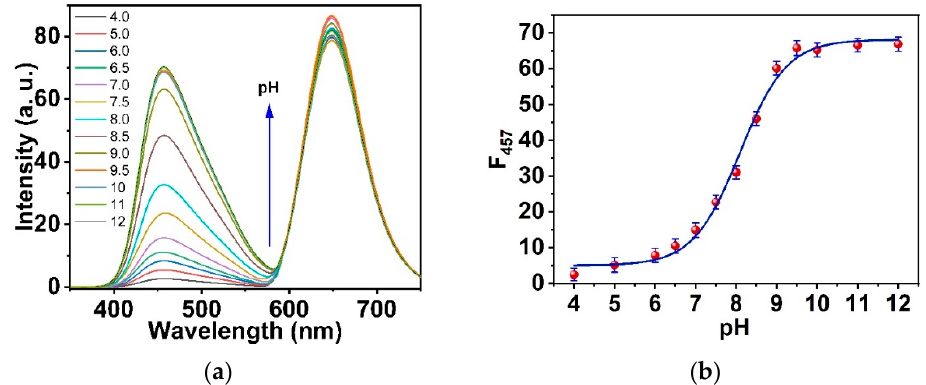
Figure 9. ( a ) The emission of the ormosil nanosensor in different pH buffer solutions ranging from 4–12; ( b ) the corresponding calibration curve of the intensity at 457 nm of the ormosil nanosensor at different pH.